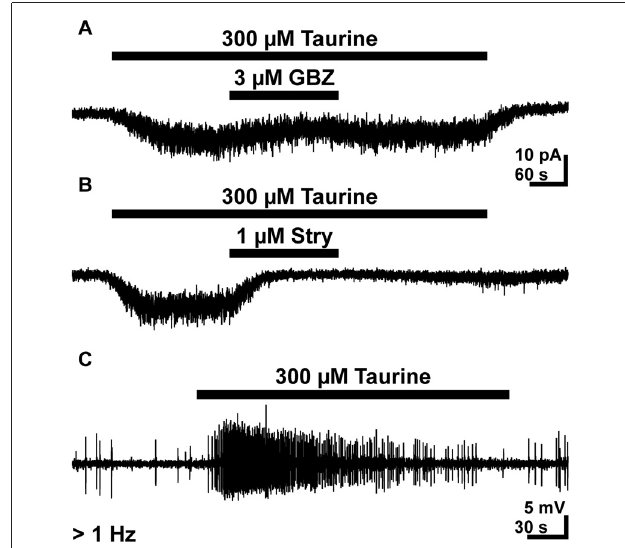
FIGURE 8 | Effect of taurine on GABAergic interneurons . (A) Typical current registration illustrating that bath application of 300 µ M taurine induced an inward current that was attenuated by 3 µ M gabazine (GBZ). (B) The taurine-induced inward currents revealed a stronger attenuation in the presence of 1 µ M strychnine. A and B were recorded in the continuous presence of 0.5 µ M TTX. (C) Typical cell-attached recording illustrating that bath-application of 300 µ M taurine increases the frequency of APs in GABAergic interneurons.